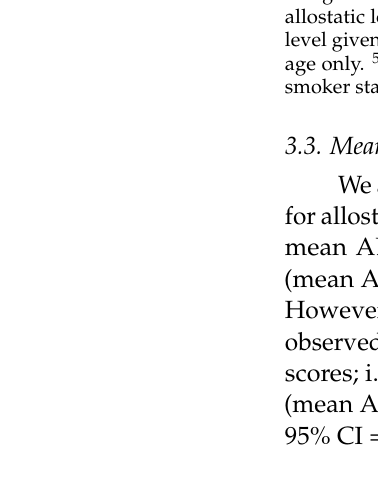
Table 3. Prevalence Association between education and adjusted mean estimates of allostatic load and Associated 95% confidence intervals (CIs), Among 4113 participants, using NHANES weighting an estimated 8,116,464 US Black